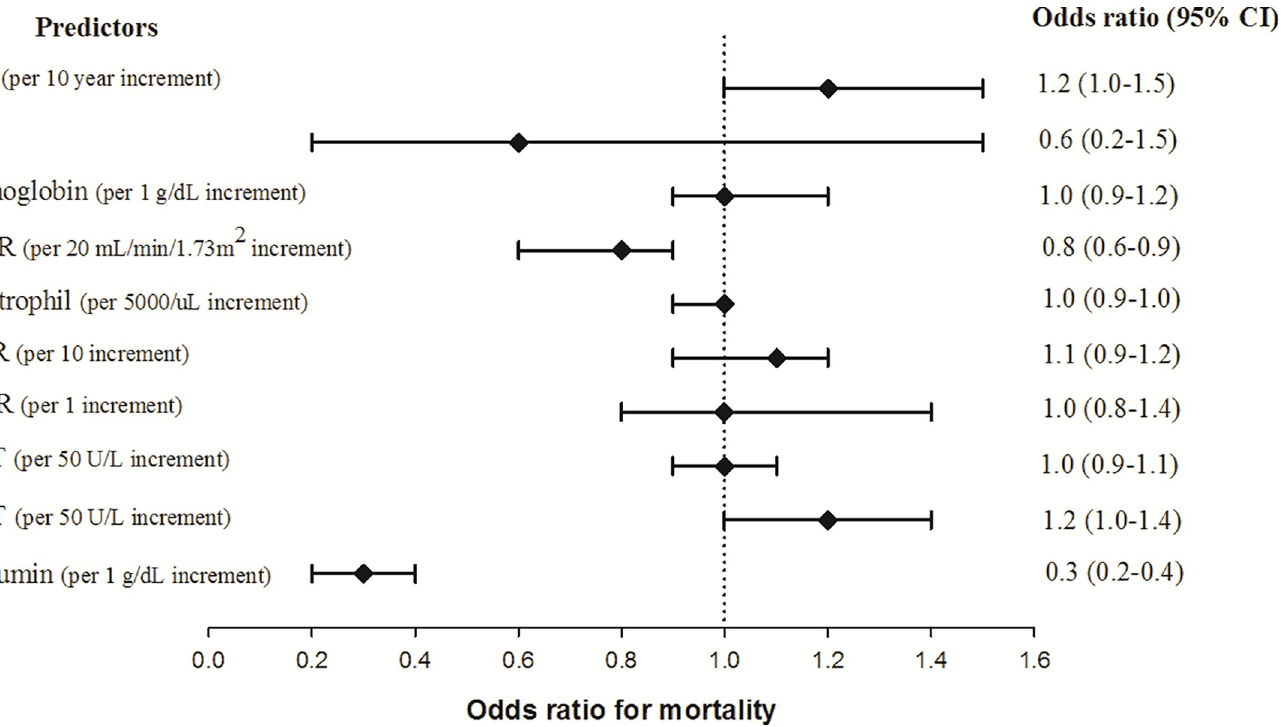
Fig 1. Risk factors for in-hospital mortality in patients with pneumonia. Odds ratio for mortality was calculated by multivariate logistic regression. DM, diabetes mellitus; eGFR, estimated glomerular filtration rate; NLR, neutrophil-to-lymphocyte ratio; MLR, monocyte-to-lymphocyte ratio; AST, aspartate aminotransferase; ALT, alanine aminotransferase, CI, confidence